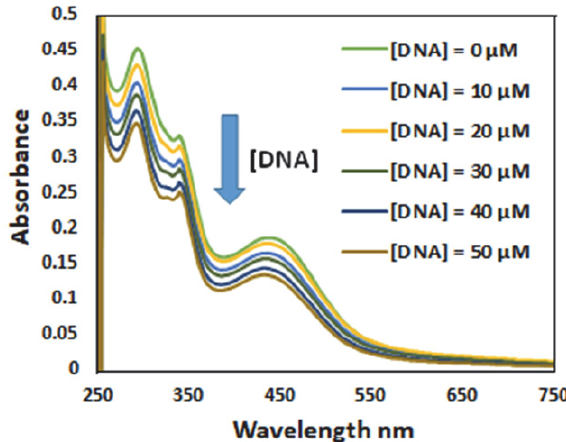
Table 1 Binding constant (K b ), percentage hypochromicity (%H), bathochromicity (Δλ), and Gibbs free energy ( ΔG° ) values of free ligands and synthesized complexes